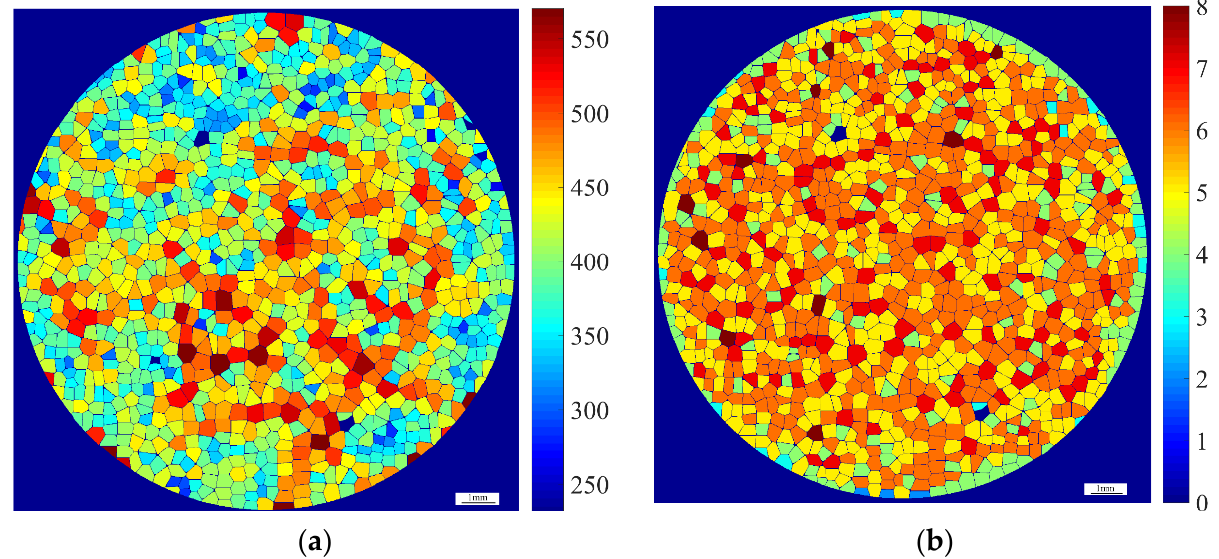
Figure 10. The distribution of PDAS and coordination number of HT901 in full field of view. ( a ) PDAS distribution, ( b ) coordination number distribution.